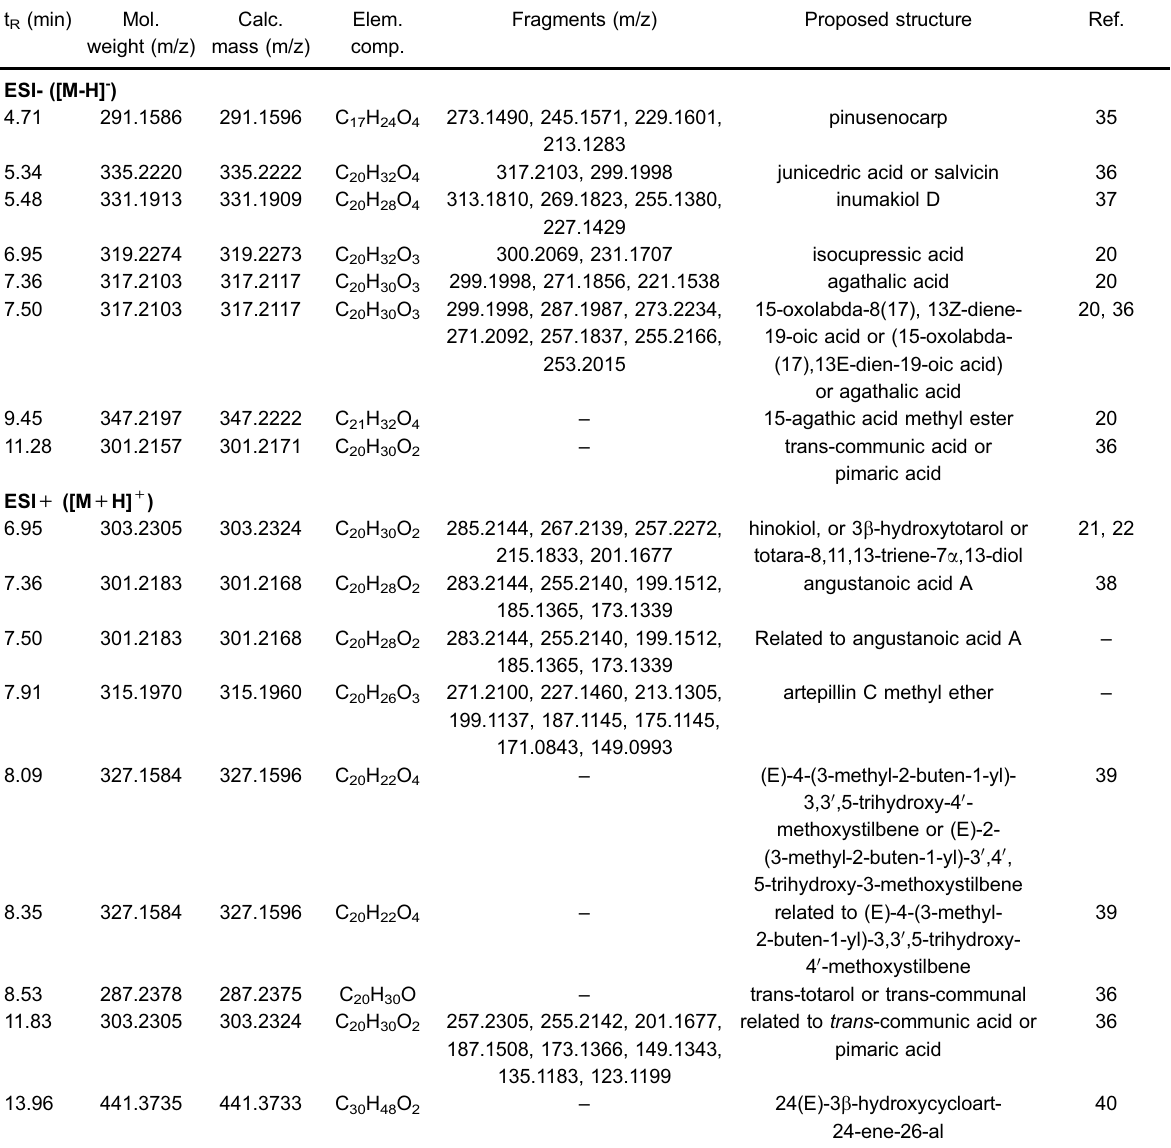
Table 1. Identi fi cation of compounds in ethanolic crude extract from the propolis of M. quadrifasciata quadrifasciata by UPLC-MS/MS and ESI-QTOF/MS analysis, in negative and positive mode. t R (min)